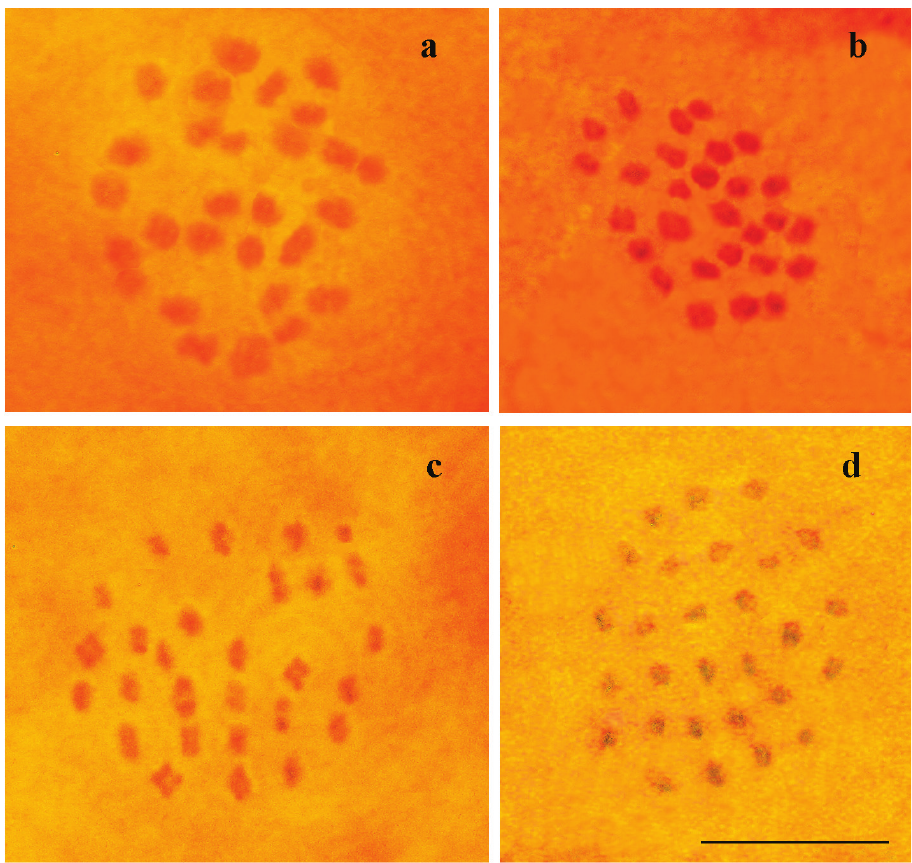
Figure 1. Karyotypes in male meiosis of Melitaea gina from Iran. a sample Q183, prometaphase I, n = 28 b sample Q153, late prometaphase I, n = 28 c sample Q183, MI, n = 28 d sample Q155, M I, n = 28. Scale bar corresponds to 10µ in all